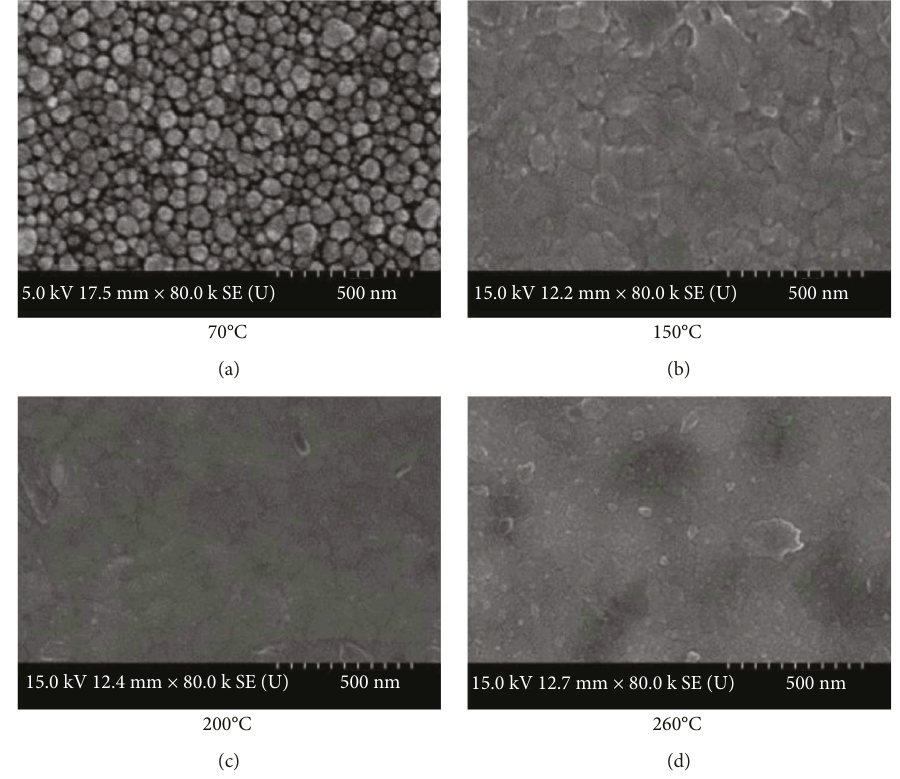
Figure 5: SEM images of IJP-printed Ag lines after di ff erent curing temperatures. Reproduced with permission [81].